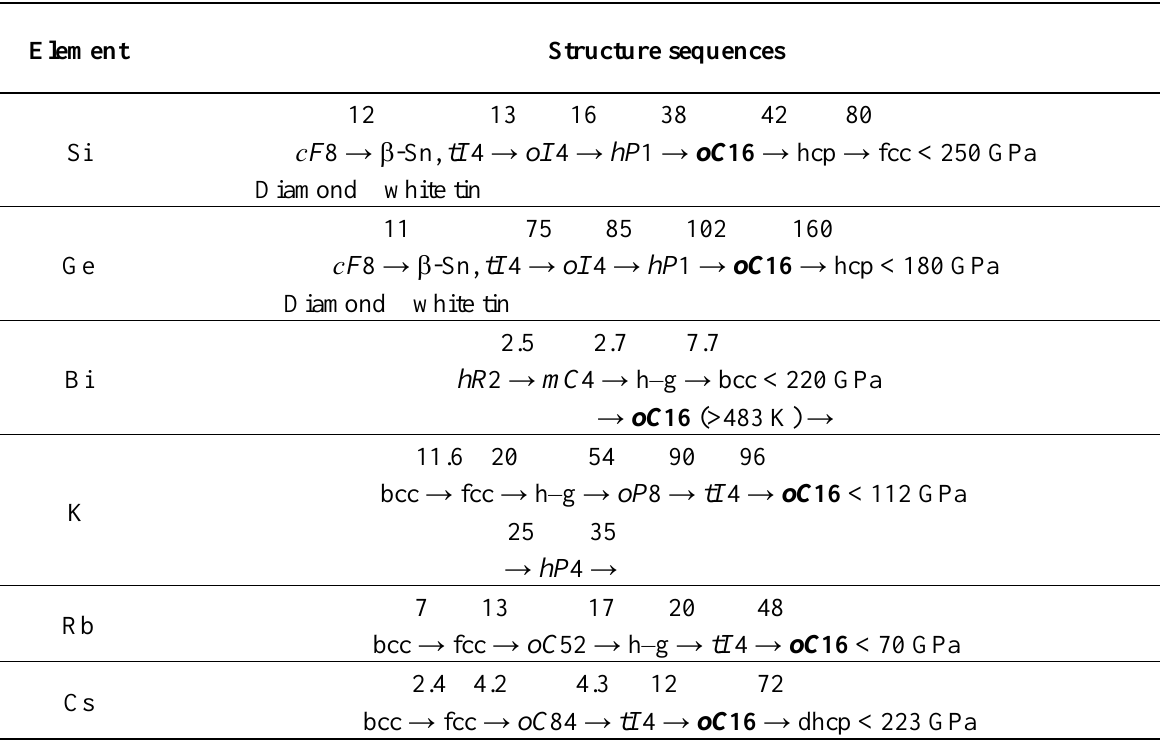
Table 1. Sequences of structural transformations on pressure increase for elements with the oC 16